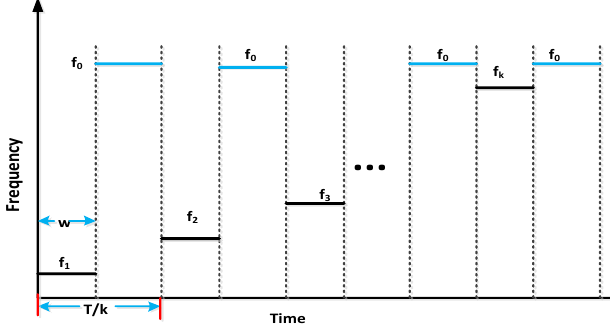
Figure 6. Analysis of a sequence based on frequency coding.